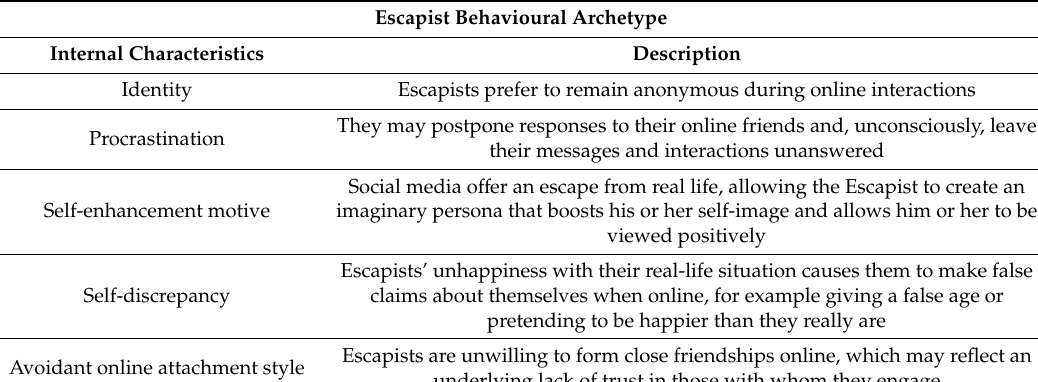
Table 7. Overview of the Escapist behavioural